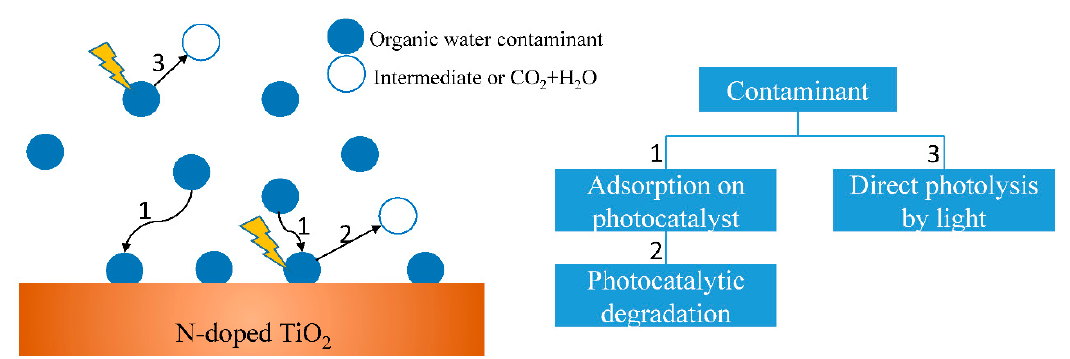
Figure 1. Schematic of the different mechanisms involved in the degradation of contaminants by N-TiO 2 photocatalysts.